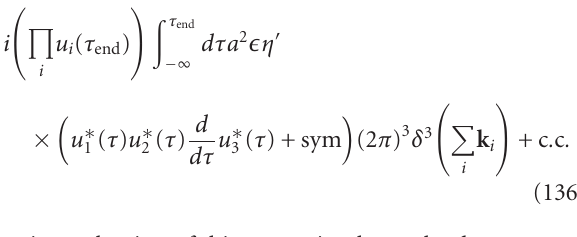
in which the coupling is proportional to ˙ η . The